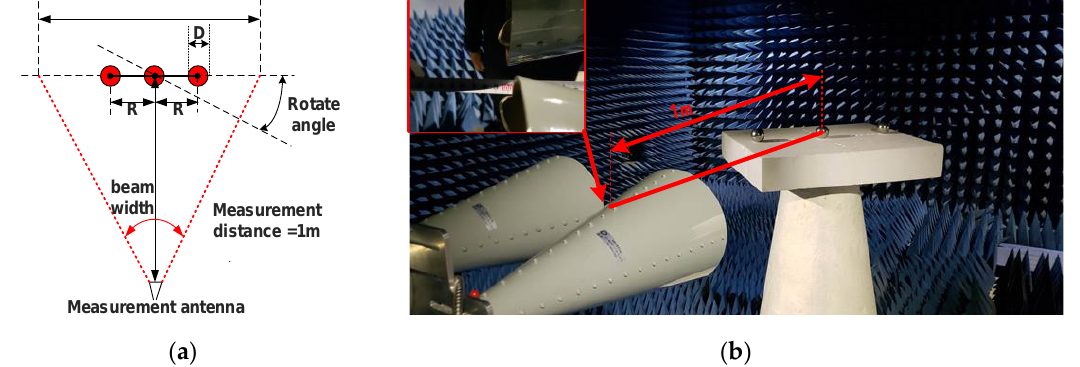
Figure 11. The experiment setup: ( a ) the experiment analyzes and design; ( b ) experiment environment.